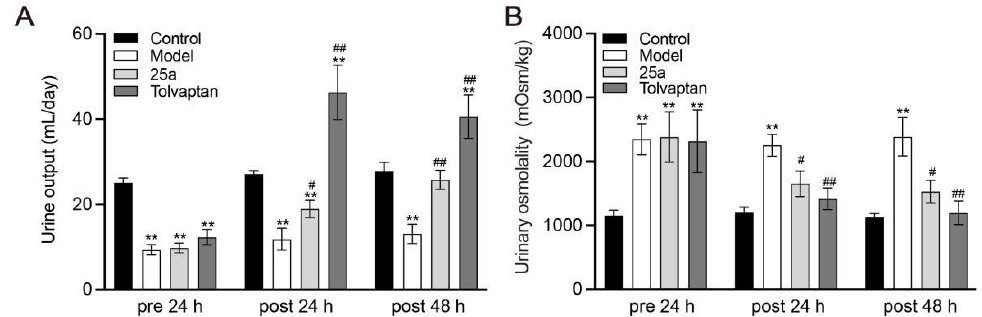
Figure 2. Daily urine output and urinary osmolality in rats. ( A ) Daily urine output. ( B ) Urinary osmolality. Data are presented as means ± SEM, n = 7. * p < 0.05 and ** p < 0.01 vs. control group; # p < 0.05 and ## p < 0.01 vs. model group by one- way ANOVA with Tukey’s HSD post hoc test .